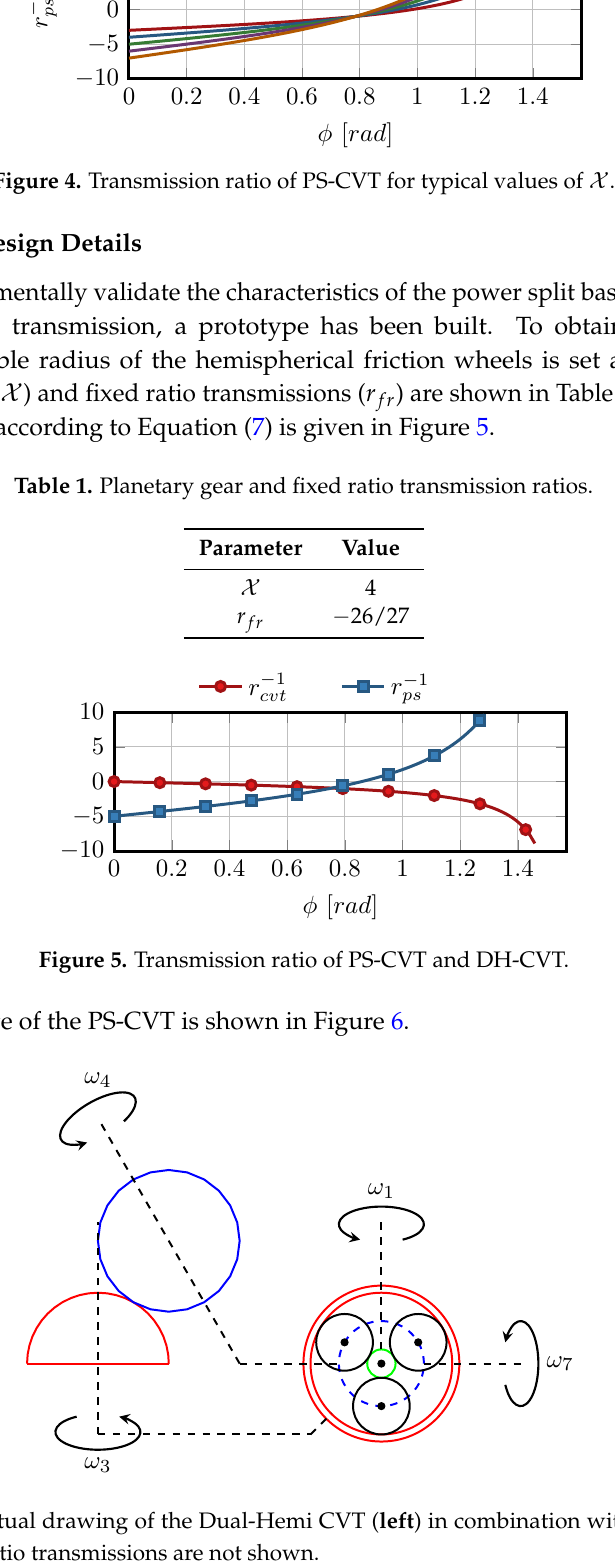
Figure 6. A conceptual drawing of the Dual-Hemi CVT ( left ) in combination with a planetary gear ( right ). The fixed ratio transmissions are not